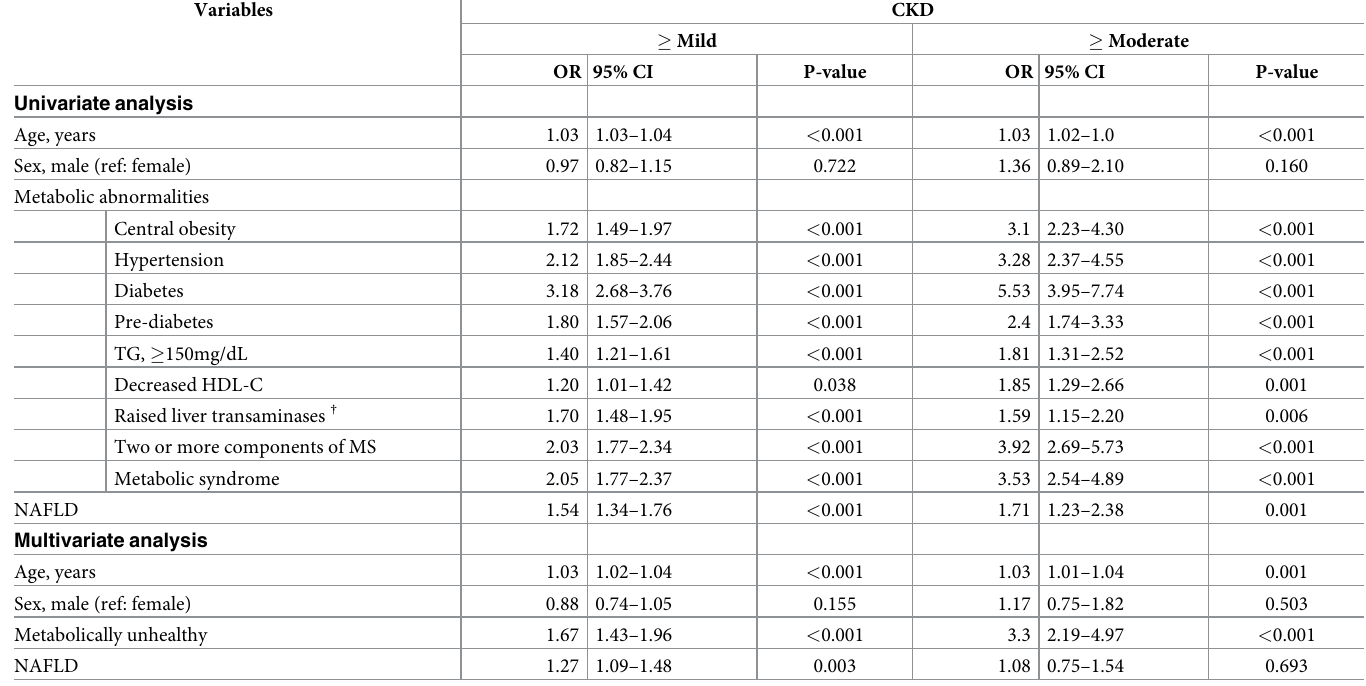
Table 2. Association of CKD with metabolic abnormalities and NAFLD in study